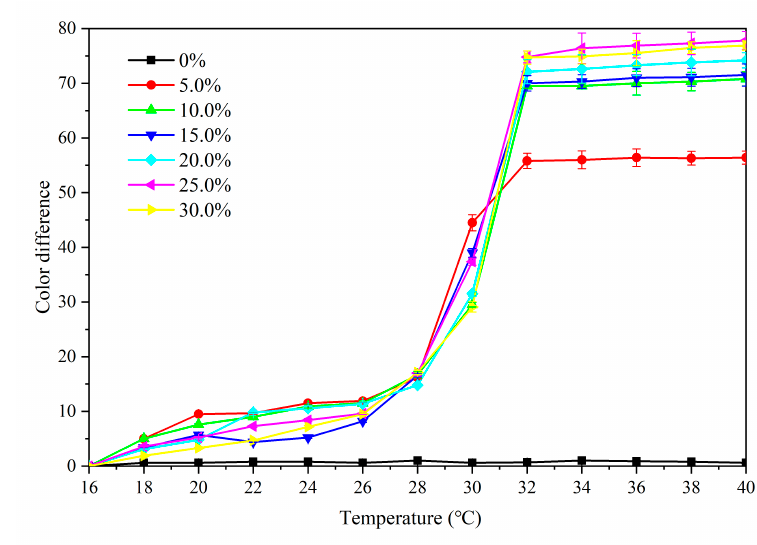
Figure 10. Effect of temperature increase (16–40 °C) on color difference of primer film with microcapsules.